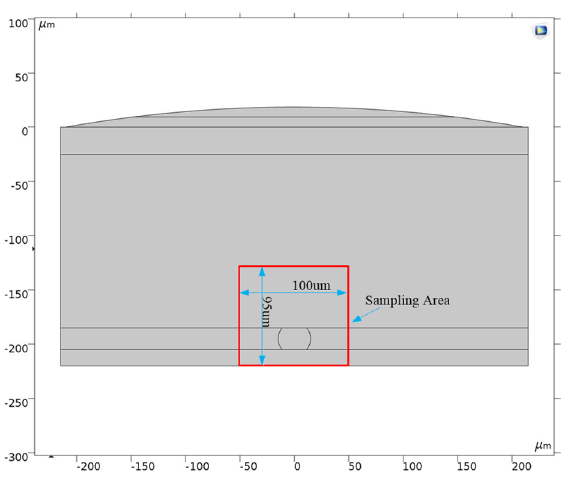
Figure 6. Sampling area in the model.